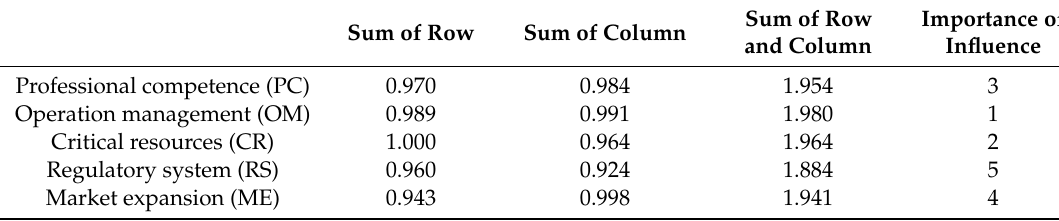
Table 6. The degree of direct influence.